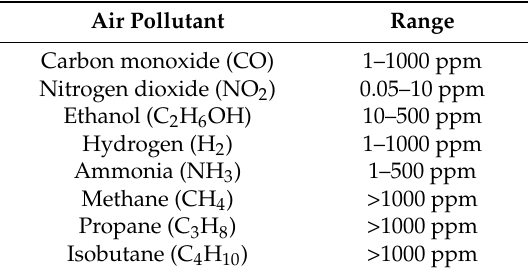
Table 1. Gases monitored by the iAir system.